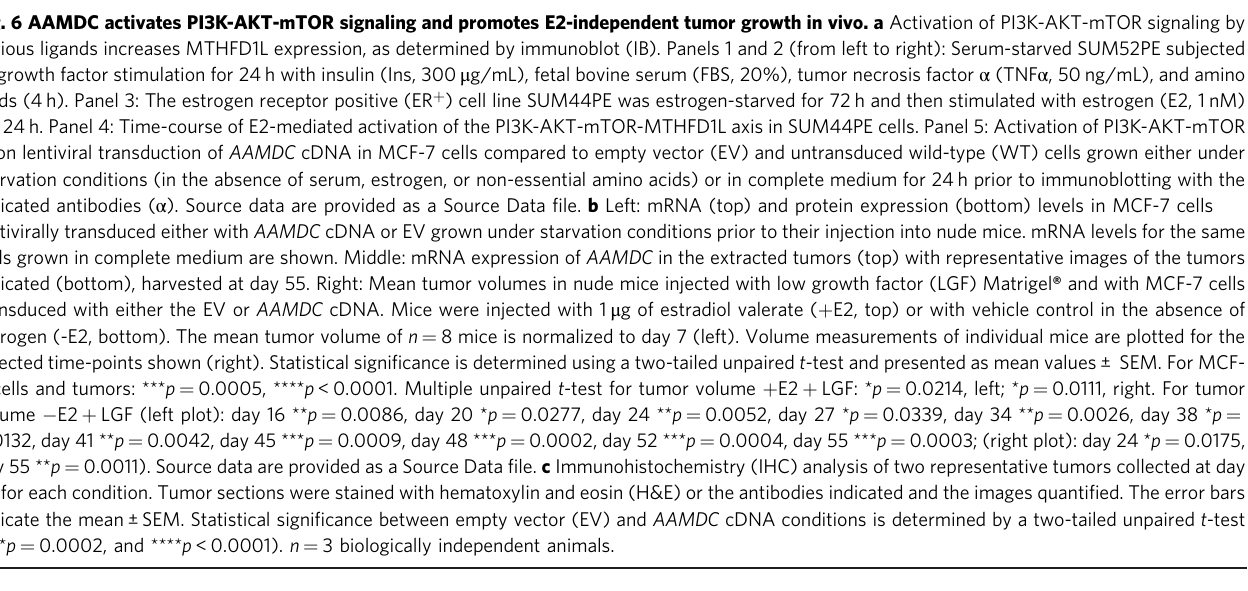
Fig. 6 AAMDC activates PI3K-AKT-mTOR signaling and promotes E2-independent tumor growth in vivo. a Activation of PI3K-AKT-mTOR signaling by various ligands increases MTHFD1L expression, as determined by immunoblot (IB). Panels 1 and 2 (from left to right): Serum-starved SUM52PE subjected to growth factor stimulation for 24 h with insulin (Ins, 300 μ g/mL), fetal bovine serum (FBS, 20%), tumor necrosis factor α (TNF α , 50 ng/mL), and amino acids (4 h). Panel 3: The estrogen receptor positive (ER + ) cell line SUM44PE was estrogen-starved for 72 h and then stimulated with estrogen (E2, 1 nM) for 24 h. Panel 4: Time-course of E2-mediated activation of the PI3K-AKT-mTOR-MTHFD1L axis in SUM44PE cells. Panel 5: Activation of PI3K-AKT-mTOR upon lentiviral transduction of AAMDC cDNA in MCF-7 cells compared to empty vector (EV) and untransduced wild-type (WT) cells grown either under starvation conditions (in the absence of serum, estrogen, or non-essential amino acids) or in complete medium for 24 h prior to immunoblotting with the indicated antibodies ( α ). Source data are provided as a Source Data fi le. b Left: mRNA (top) and protein expression (bottom) levels in MCF-7 cells lentivirally transduced either with AAMDC cDNA or EV grown under starvation conditions prior to their injection into nude mice. mRNA levels for the same cells grown in complete medium are shown. Middle: mRNA expression of AAMDC in the extracted tumors (top) with representative images of the tumors indicated (bottom), harvested at day 55. Right: Mean tumor volumes in nude mice injected with low growth factor (LGF) Matrigel ® and with MCF-7 cells transduced with either the EV or AAMDC cDNA. Mice were injected with 1 μ g of estradiol valerate ( + E2, top) or with vehicle control in the absence of estrogen (-E2, bottom). The mean tumor volume of n = 8 mice is normalized to day 7 (left). Volume measurements of individual mice are plotted for the selected time-points shown (right). Statistical signi fi cance is determined using a two-tailed unpaired t -test and presented as mean values ± SEM. For MCF- 7 cells and tumors: *** p = 0.0005, **** p < 0.0001. Multiple unpaired t -test for tumor volume + E2 + LGF: * p = 0.0214, left; * p = 0.0111, right. For tumor volume − E2 + LGF (left plot): day 16 ** p = 0.0086, day 20 * p = 0.0277, day 24 ** p = 0.0052, day 27 * p = 0.0339, day 34 ** p = 0.0026, day 38 * p